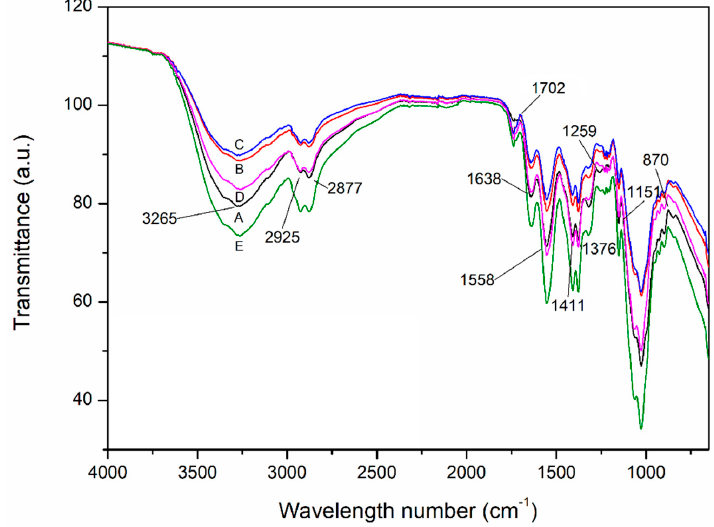
Figure 2. ATR-FTIR spectra of chitosan (Ch)-based films ( A ) incorporated with: ( B ) MMT; ( C ) MMT + 0.5% GEO; ( D ) MMT + 1% GEO; and ( E ) MMT + 2%